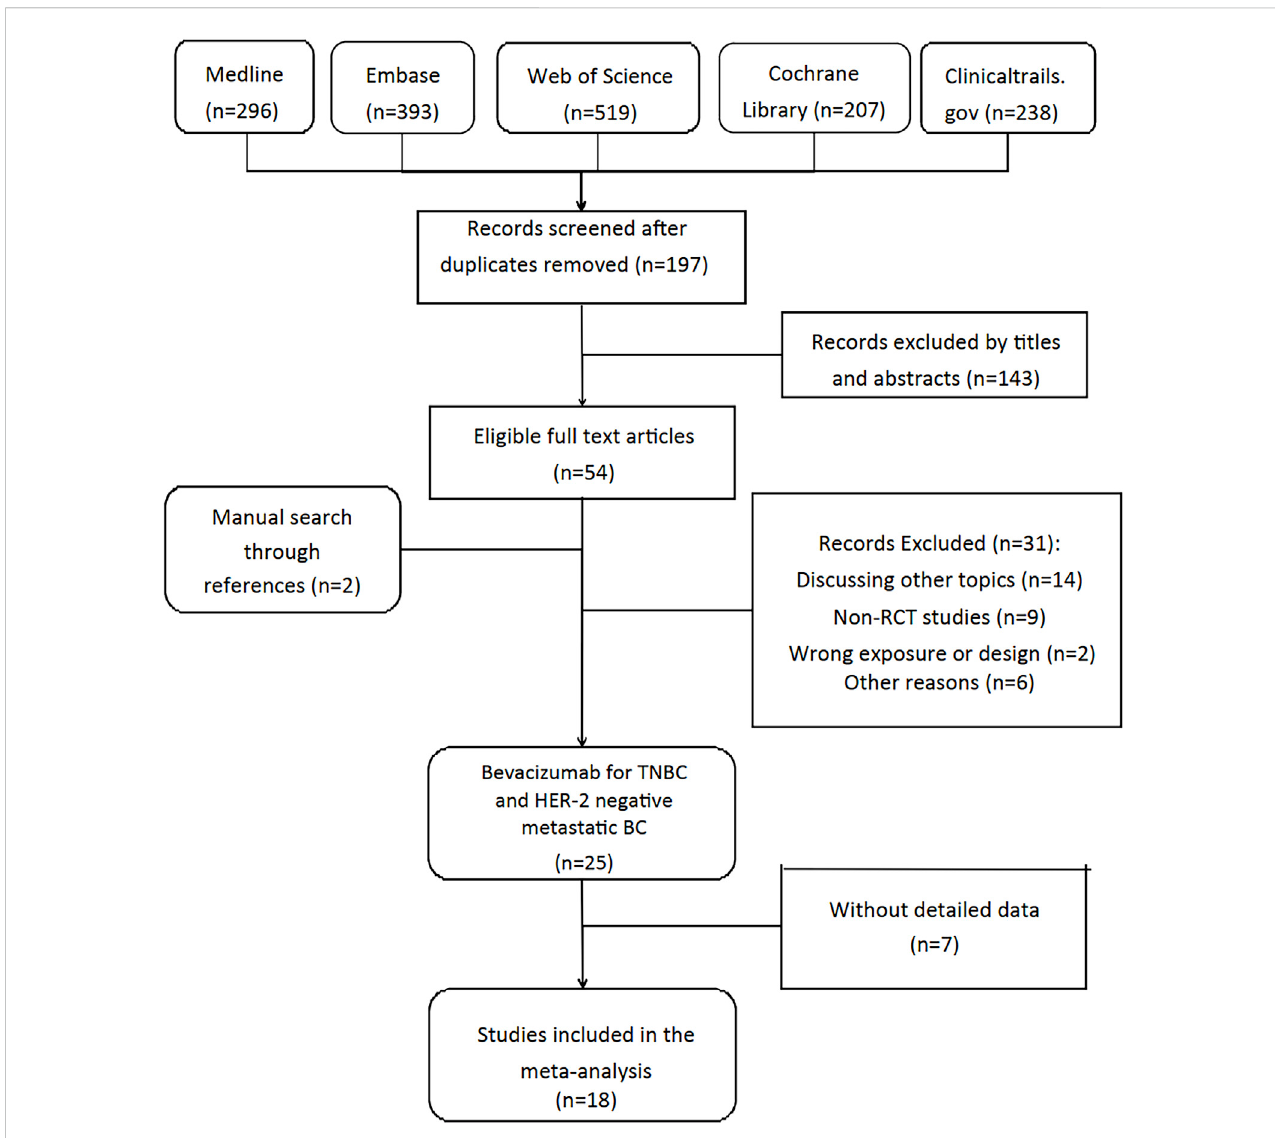
FIGURE 1 Flowchart of selection of included